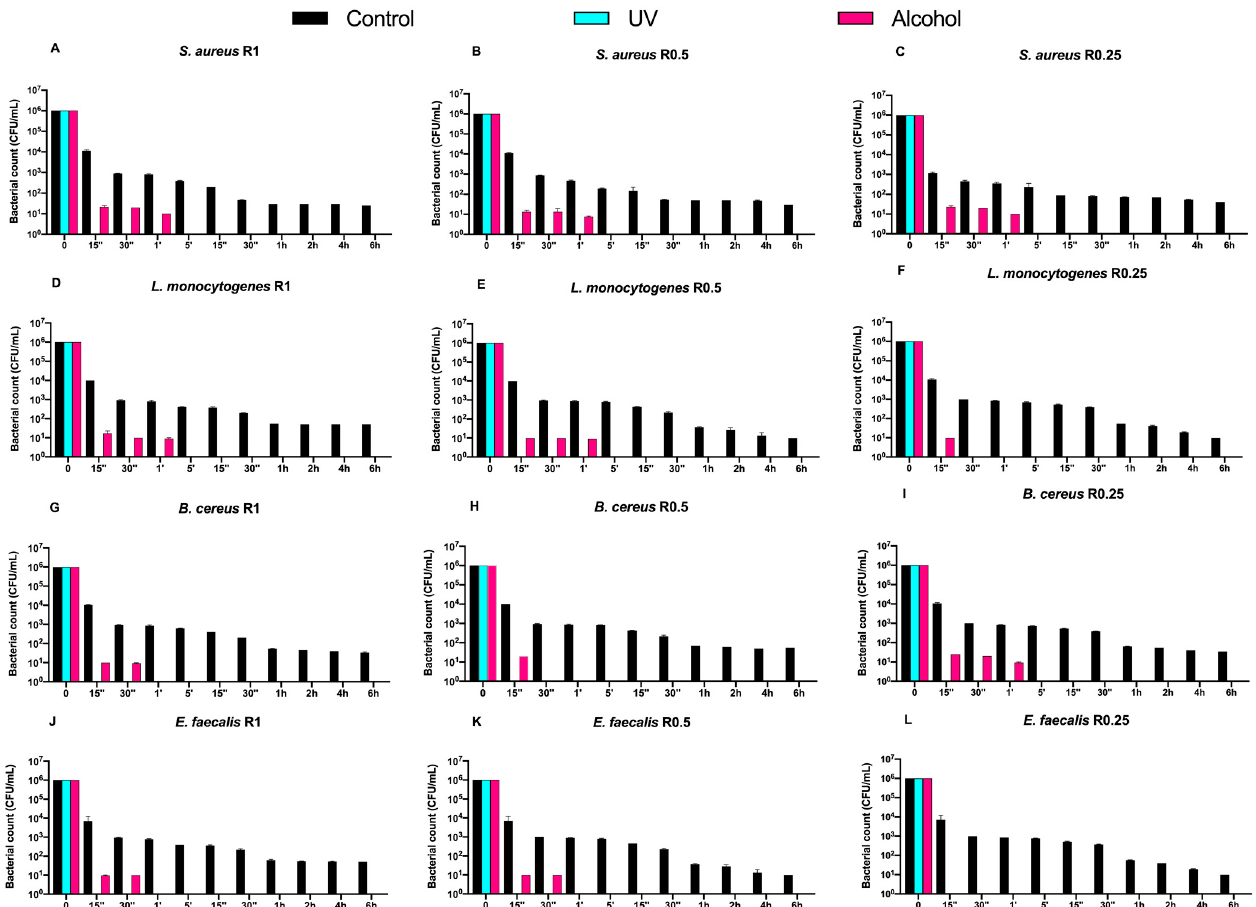
Figure 3. Graphical representation of Gram-positive bacterial ( A – L ) counts at different exposure times on DURALTI ® -coated aluminum disks with different surface roughness (R0.25, R0.5 and R1 µ m) and subjected to UV and alcohol sanitizing